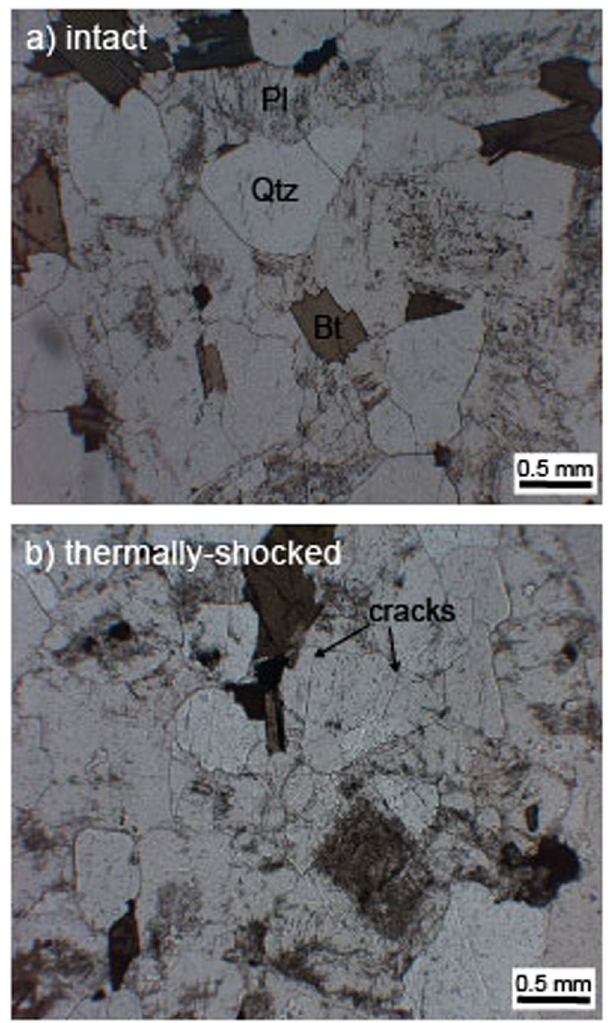
Figure 1. Thin section photomicrographs (taken using an optical microscope under transmitted, polarised light) of ( a ) intact Westerly granite and ( b ) Westerly granite thermally-shocked to 450 °C. Qtz – quartz; Pl – plagioclase; Bt –